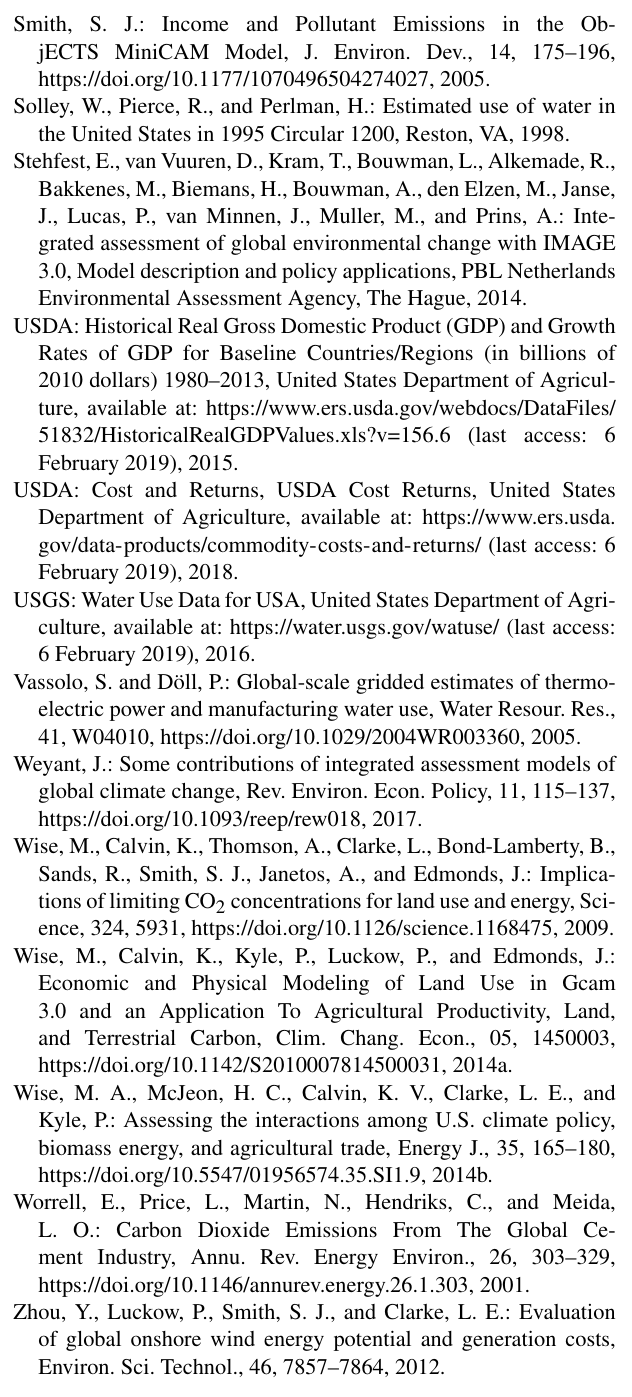
Tabeau, A., and Tavoni, M.: The Shared Socioeconomic Path- ways and their energy, land use, and greenhouse gas